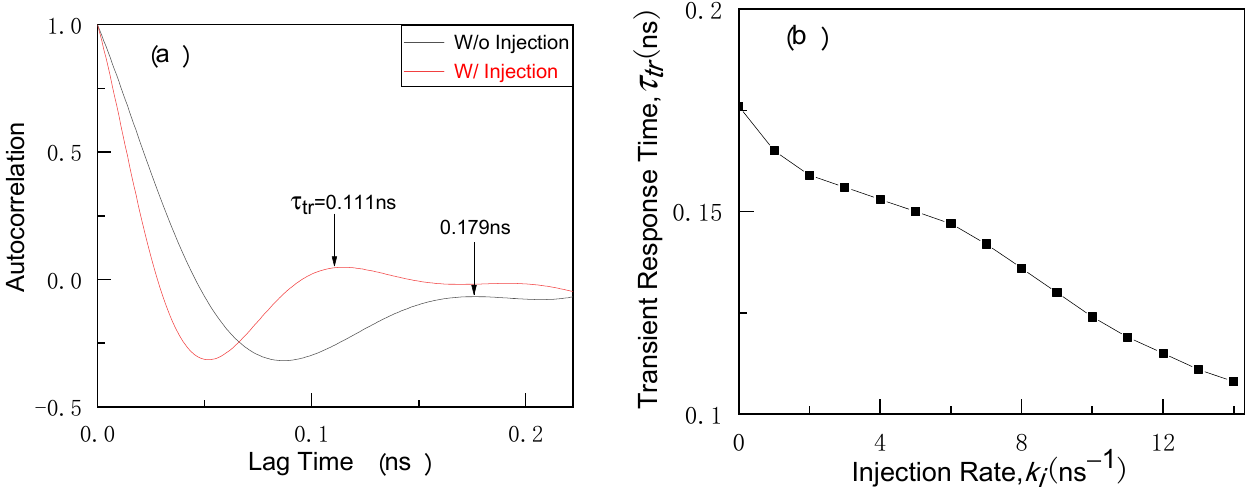
Figure 2. ( a ) Autocorrelation of the impulse response of response laser with ( k i = 12 ns − 1 , ∆ ν i = ∆ ν s ) and without ( k i = 0 ns − 1 ) master laser injection. ( b ) Transient response time τ tr as a function of injection rate k i .